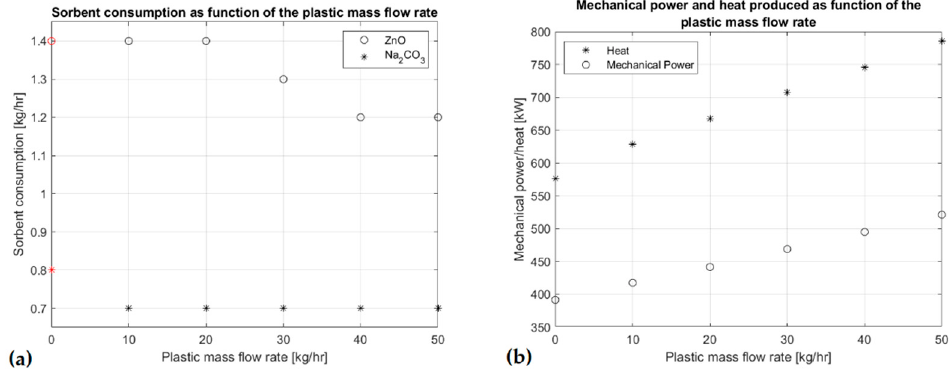
Figure 14. ( a ) Sorbent consumption as a function of plastic fraction; ( b ) mechanical power and heat recovered as a function of plastic fraction.